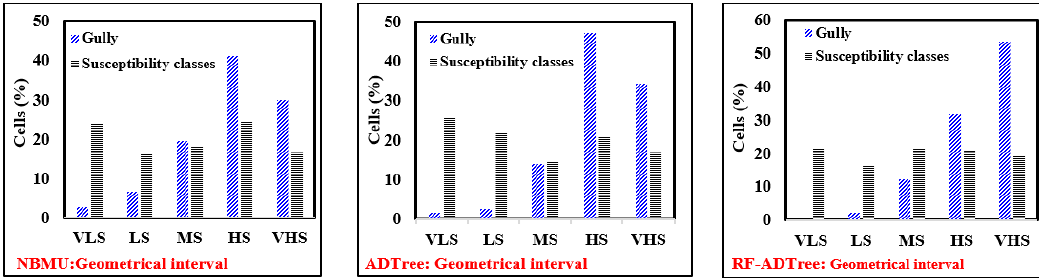
Figure 6. Histograms of all models for selecting the best classification method of gully susceptibility maps.